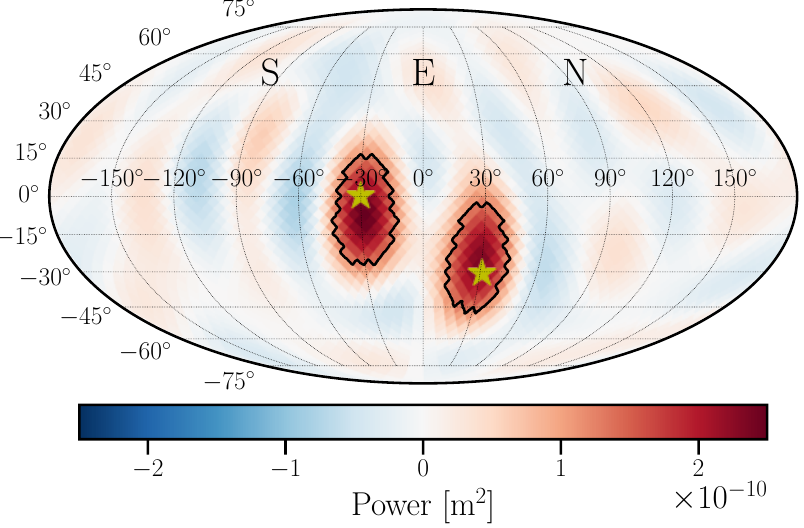
Figure 4. Recovery of two pressure waves is shown, with their true propagation directions indicated by stars. The contours, defined to enclose 95% of the total power, amount to the total recovered power of 2.6 10 − 8 m 2 , as compared to the simulated 2 10 − 8 m 2 . This discrepancy is caused × × by the coherence between the two signals, breaking one of the underlying assumptions of our inversion